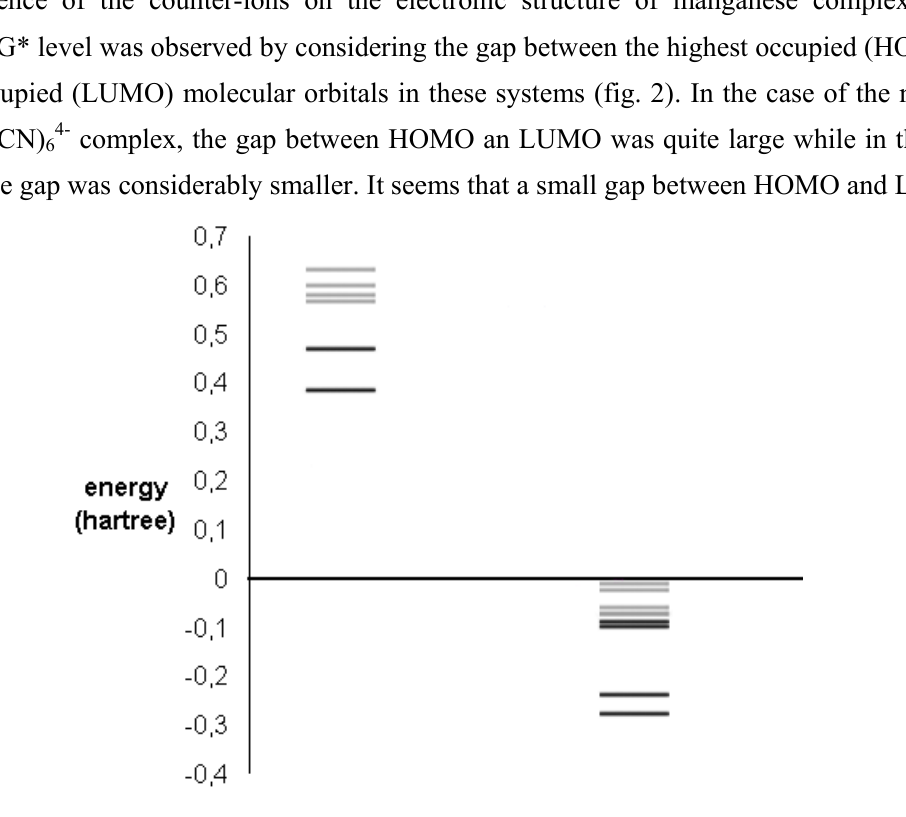
[MnCN ] (on the right) orbitals calculated at B3LYP/3-21G* 4 6 [MnCN ] complex is much smaller than that for the 4 6